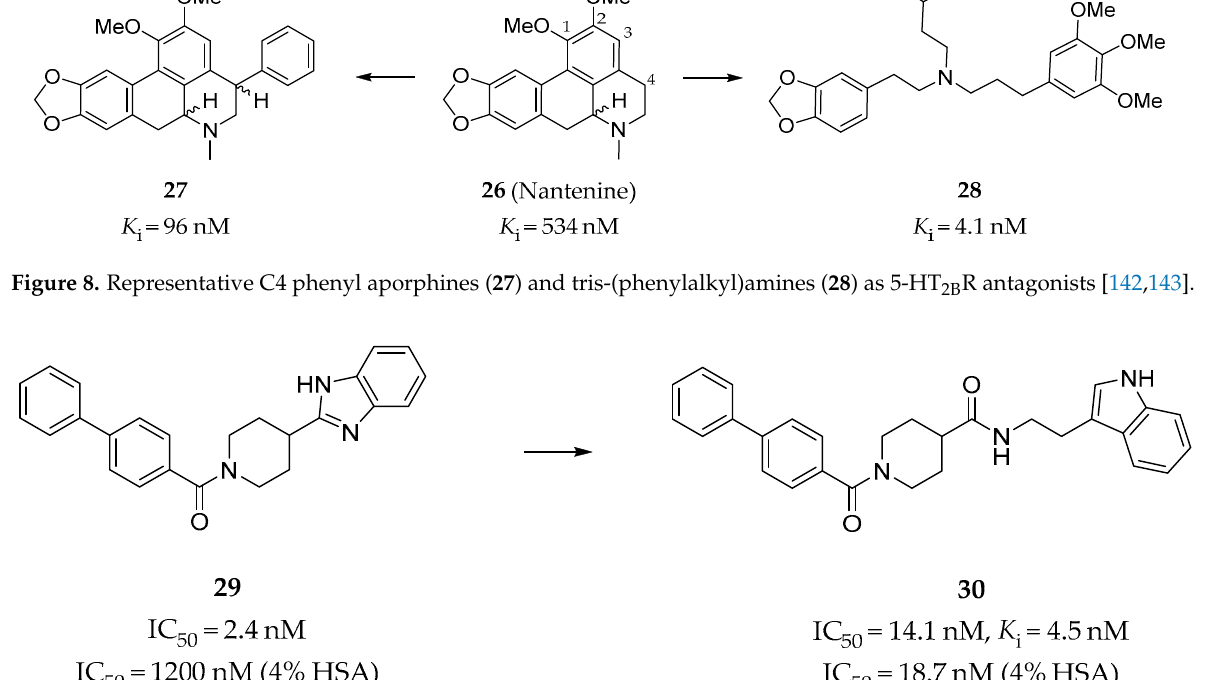
Figure 10. Representative chromane derivatives as 5-HT 2B R high-affinity ligands [146]. 4.2.8. Other pharmaceutical ligands of the 5-HT 2B R In 2010, a urea type of ligand 34 ( K i = 42 nM, Table 3) was coincidentally discovered as a 5-HT 2B R antagonist by Kwon et al. [147]. Notably, this compound showed strong se- lectivity for the 5-HT 2B R over other serotonin receptors, as well as dopamine, histamine, muscarinic and opiate receptors. In 2011, C-122 ( 35 , Table 3) was reported by Zopf et al. as a 5-HT 2B R antagonist ( K i = 5.2 nM) [148]. It is worth mentioning that C-122 is not selec- tive for the 5-HT 2B R and also exhibit binding affinities against serotonin receptors such as the 5-HT 7 R ( K i = 4.4 nM), the 5-HT 2A R ( K i = 61 nM), and several other monoaminergic GPCRs. In vivo studies on the MCT-induced PAH rat model showed that C-122 prevented MCT-induced elevations in the pulmonary arterial circuit pressure, right ventricular hy- pertrophy and pulmonary arteriole muscularization when orally administered at 10 mg/kg daily for 3 weeks [148]. In 2015, Rodrigues et al. carried out a proof-of-concept study of a large-scale multidimensional de novo design approach, combining computa- tional molecular design and quantitative activity prediction with microfluidics synthesis, and discovered new chemical entities for the 5-HT 2B R [149]. Several computationally de- signed compounds with a good predicted affinity and selectivity were subjected to exper- imental validation. As a result, piperazine 36 (Table 3) was identified as a 5-HT 2B R antag- onist ( K i = 251 nM), with high binding and functional selectivity [149]. In 2016, considering that adenosine derivatives were reported with micromolar activity at the 5-HT 2B R and the 5-HT 2C R, Tosh et al. applied a structure-based drug design approach to further improve